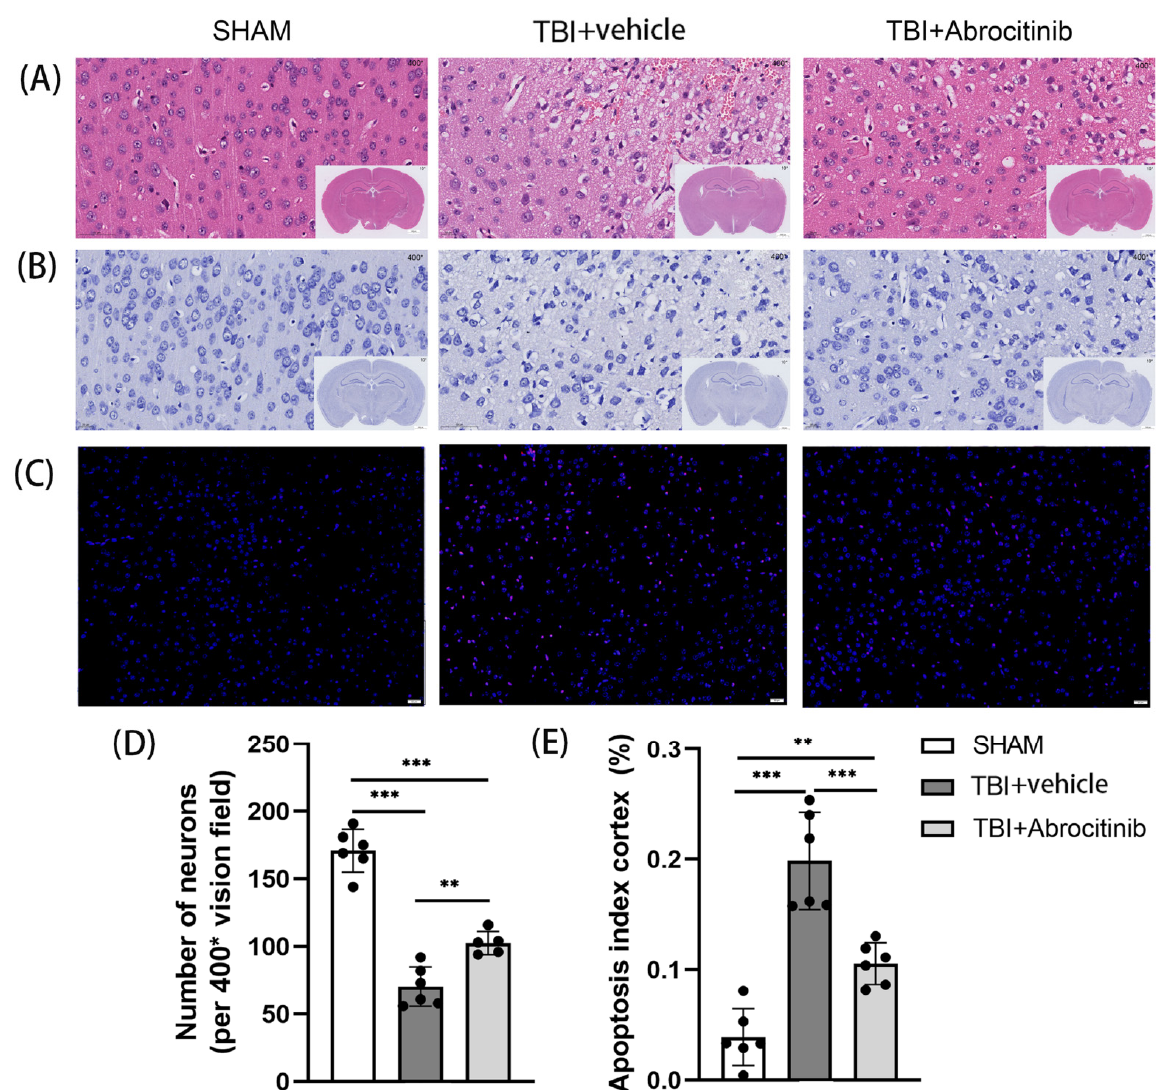
Figure 3. Changes in pathological morphology. Morphological changes were observed using H&E staining ( A ). The number of surviving neurons ( B , D ) and the changes in apoptotic cells around the wound focus were observed via Nissl staining and TUNEL staining, respectively (DAPI—blue; TUNEL—red) ( C , E ) (n = 6, one-way ANOVA with Tukey’s post-hoc test). All data are shown as mean ± SD. * p < 0.05, ** p < 0.01, *** p < 0.001.